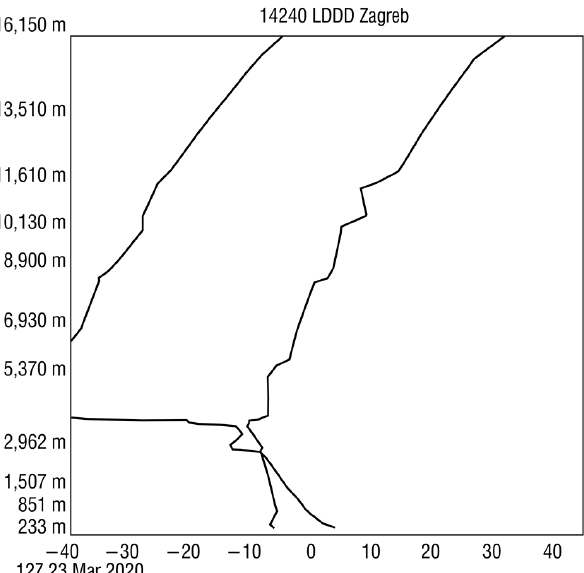
Figure 4. Vertical profiles of air temperature (right) and dew point (left) based on probing data over Zagreb, Croatia, on 11 March 2020, 12:00 UTC. The right solid black curve is profile of the air temperature while left black solid curve is the dewpoint profile, heights at which significant differences in temperature profiles occur compared to the standard atmosphere (so-called “significant levels”) are marked (source: University of Wyoming website, URL http://weather.uwyo.edu/upperair/sounding.html, accessed on 20 September 2022).